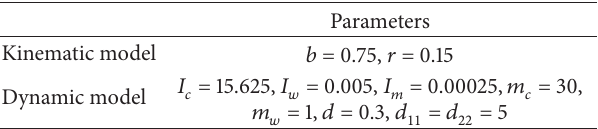
Figure 3: The trajectory of 𝑥, 𝑦 , and 𝜙 .